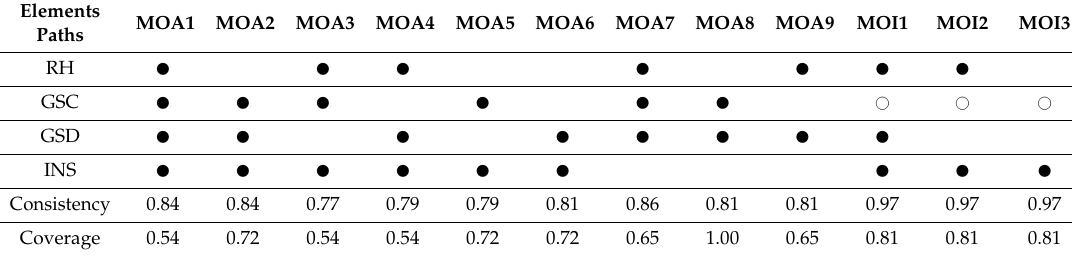
Table 8. Analysis of combinations of causal conditions of MOA and